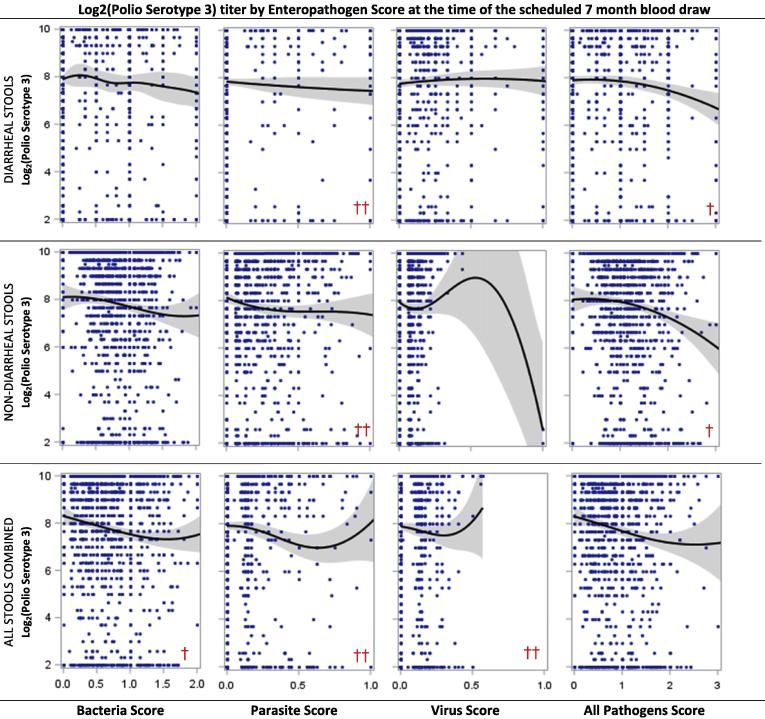
Polio serotype 3 titers by enteropathogen detection scores (bacteria, parasites, viruses, all combined) computed for diarrheal, non-diarrheal and all stools combined among children receiving at least 3 OPV doses at the scheduled 7 month blood draw. Scatter plots include penalized B-splines (10 knots) and 95% confidence intervals. A chi-square test was evaluated for each scatter plot comparing the percent of children who failed to seroconvert in a high vs. low enteropathogen score group where high was defined as the approximate 75th percentile of the enteropathogen score (i.e., 1.0, 0.33, 0.15, and 1.25 for Bacteria, Parasite, Virus and All Pathogens Scores, respectively); † indicates p < 0.05; †† indicates p < 0.01.